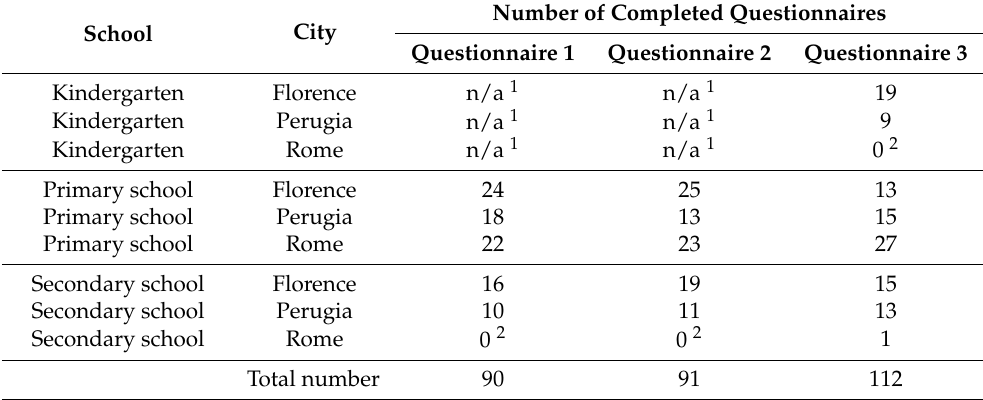
Table 5. Number of completed questionnaires in the case study